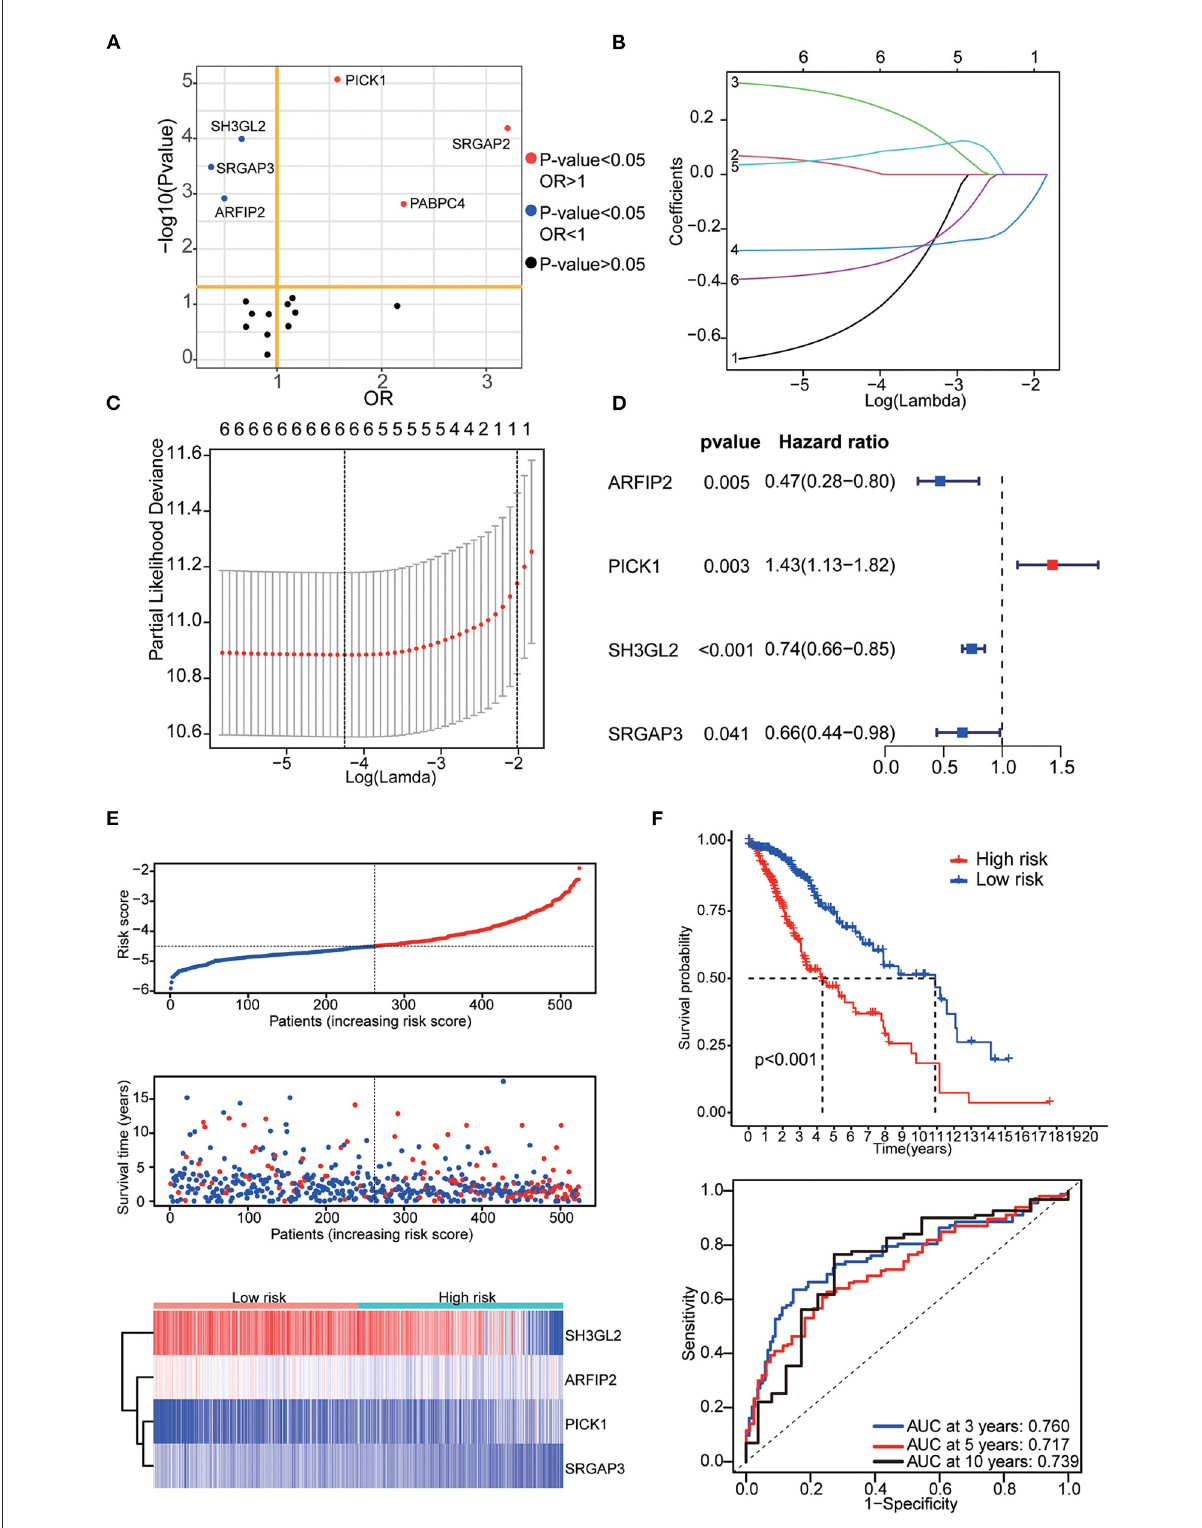
FIGURE3 (A) Results of the KM curve analysis of 17 differential expressed MTRGs. Red dots represent the genes with an impact on poor prognosis, blue dots represent genes with an impact on good prognosis, and black dots represent genes with no significant impact on prognosis. (B) Coefficients of the determined characteristics are exhibited via lambda parameters. (C) Partial probability deviance relative to log (lambda)